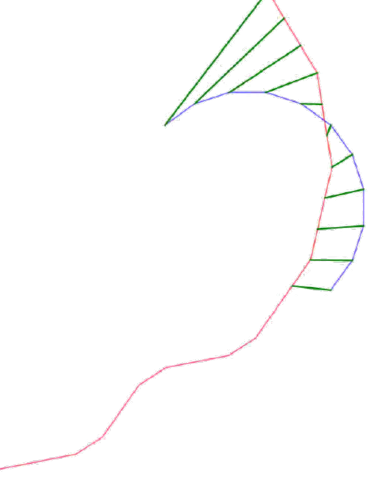
Figure 6. PCM example showing a target curve (blue) and a candidate curve (red). Both the target and candidate curves are discretised and connected into simple quadrilaterals (green). The area of each quadrilateral is calculated and accumulated over all quadrilaterals to produce a performance measure for later optimisation. In this case, the candidate curve is not required to have a complete match with the target curve, so only part of the candidate curve is